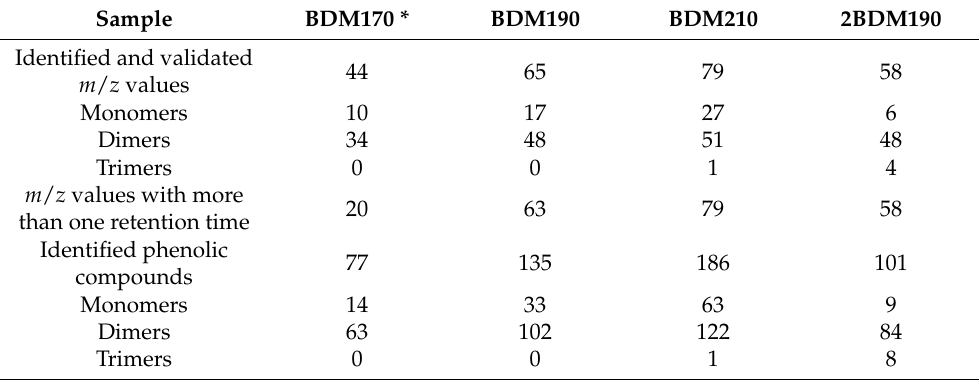
Figure 2. The base peak ion-chromatograms of BDM190 ( A ) and 2BDM190 ( B ) using the developed UHPSFC/HRMS n method. Table 1. The number of validated m / z values identified as lignin monomers, dimers, or trimers, the number of m / z values with more than one retention time, and the number of aromatic compounds identified as monomers, dimers, or trimers in the depolymerized BLR